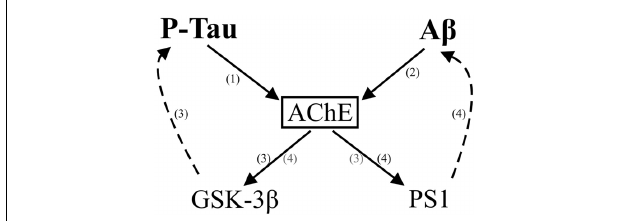
FIGURE 6 | Schematic representation of the multiple relationships betweenAChE and theAlzheimer’s effectorsA β and P-tau. AChE is proposed to interact with both A β and P-tau. P-tau can lead to an increase in the activity of AChE (1) (Silveyra et al., 2011a), whereas over-expression of N-terminally extendedT-AChE variant activates the tau kinase GSK-3 β inducing tau hyperphosphorylation (3) (Toiber et al., 2008). In addition, A β peptides can also increase AChE levels (2) (Sberna et al., 1997). In turn, AChE can affect APP processing and A β production by modulating the levels of the γ -secretase catalytic subunit PS1 (4) (Silveyra et al., 2011b). Thus, increased AChE can affect both amyloidogenic and tau hyperphosphorylation